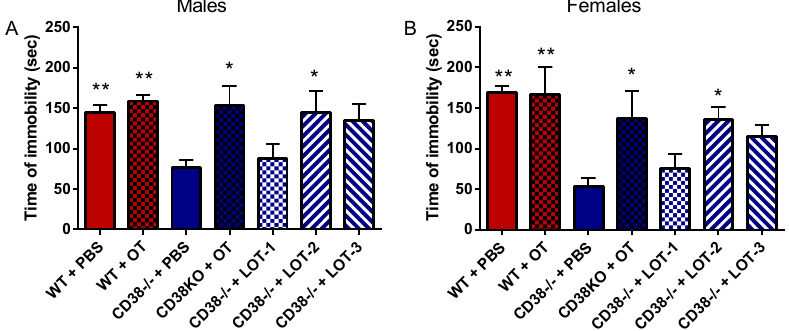
Figure 4. Tail suspension test. The immobility time by male ( A ) and female ( B ) CD38 +/+ (WT) or